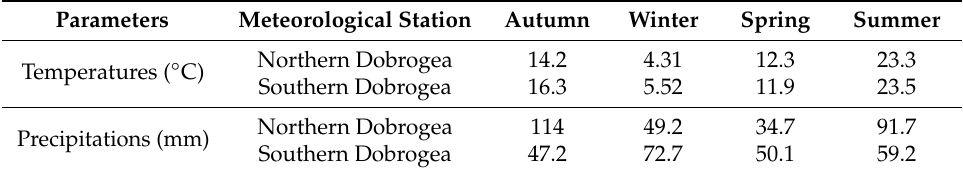
Table 2. Average temperatures and precipitation in Northern (Tulcea) and Southern Dobrogea